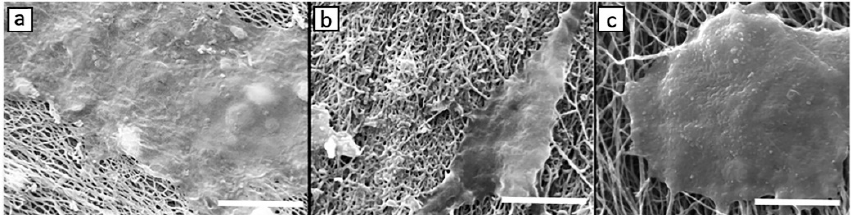
Figure 7. SEM images of MG-63 cell attachment and spreading on: ( a ) carbon nanofibrous (CNF) scaffolds without gold nanoparticles (CNF scaffold), ( b ) CNF scaffolds containing 2.5 wt% of gold nanoparticles (CNF/2.5% AuNPs), and ( c ) CNF scaffold with 5 wt% of sprayed AuNPs. Scale bar = 10 µm. Adapted from [166], Elsevier, 2020.